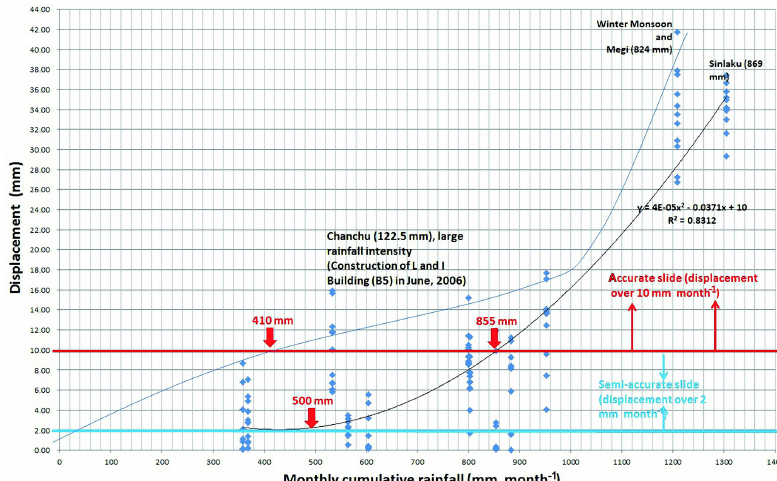
Figure 11. Relationship between monthly cumulative rainfall and displacement. The relationship curves are derived from a larger displace- ment variation of a fixed station point vs. monthly cumulative rainfall. By applying a binomial regression model, the black curve can be obtained to be the optimum relationship with a R 2 value of 0.831.